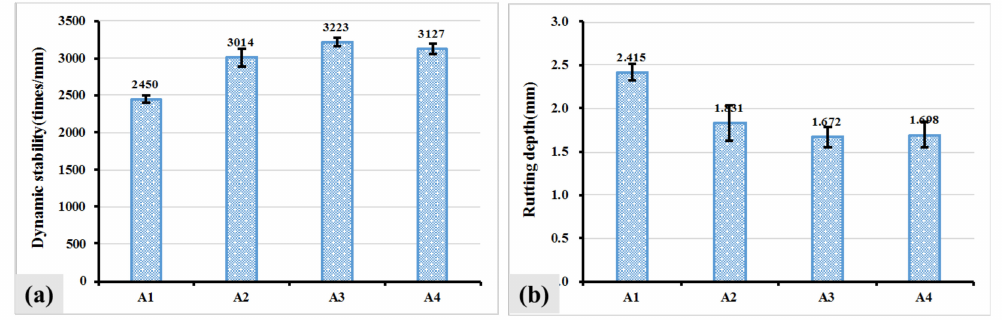
Figure 5. DS and rutting depth of asphalt mixture with the fiber: DS ( a ) and RD ( b ) of asphalt mixture.